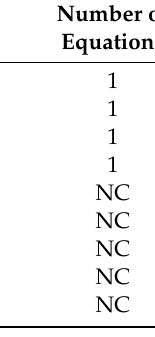
Table 2. List of equations in the DSPM model (NC—number of components). Equation Description Equations